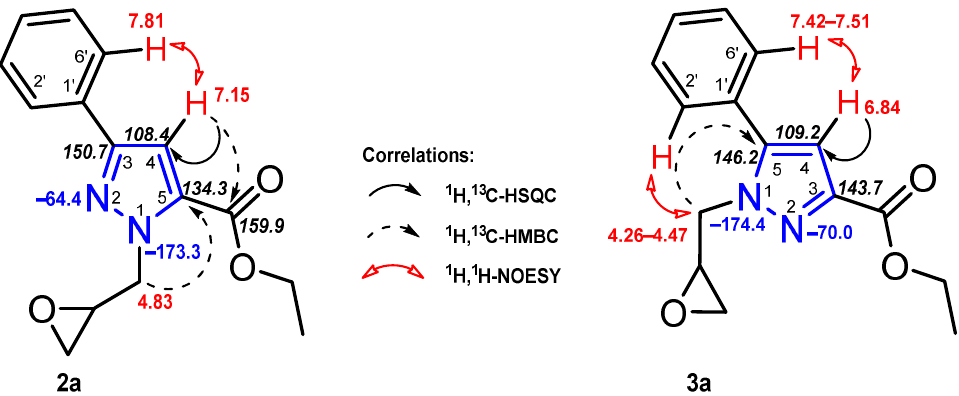
Figure 2. Relevant 1 H- 13 C-HSQC, 1 H, 13 C-HMBC, 1 H, 1 H-NOESY correlations and 1 H NMR (red), 13 C NMR (italic), 15 N NMR (blue) chemical shifts of regioisomers 2a and 3a